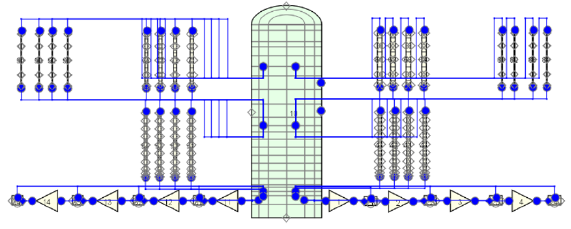
Figure 8. TRACE RPV model nodalization.